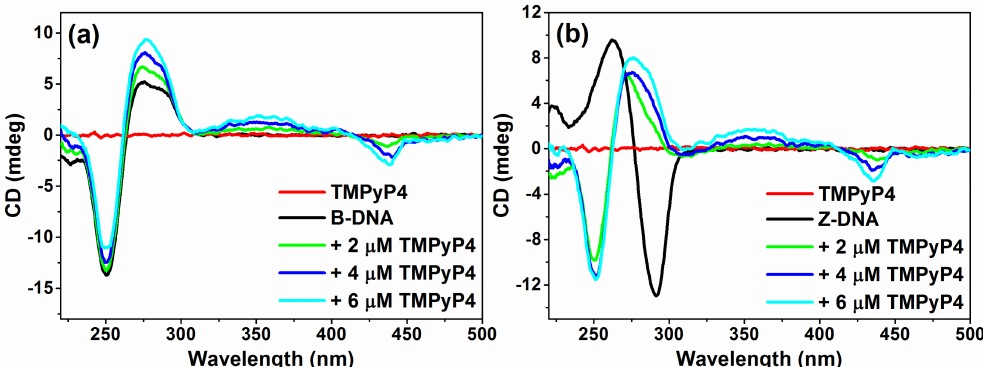
Figure 3. CD spectra of ( a ) B-DNA (50 µ M) and ( b ) Z-DNA (50 µ M) in the presence of different TMPyP4 concentrations from 2 to 6 µ M in Na-cacodylate buffer (1 mM, pH =